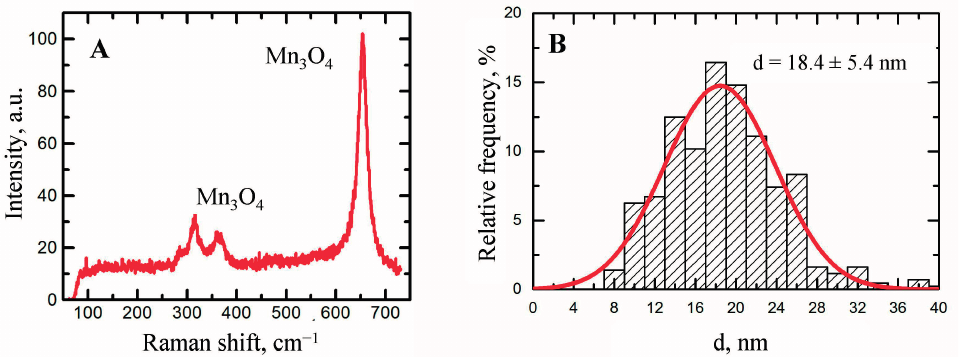
Figure 10. Characteristics of manganese oxide nanoparticles produced by laser ablation. ( A ) Raman spectrum; ( B ) size distribution function obtained by statistical processing of SEM images of